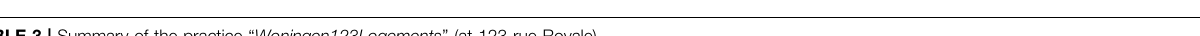
TABLE 3 | Summary of the practice “ Woningen123Logements ” (at 123 rue